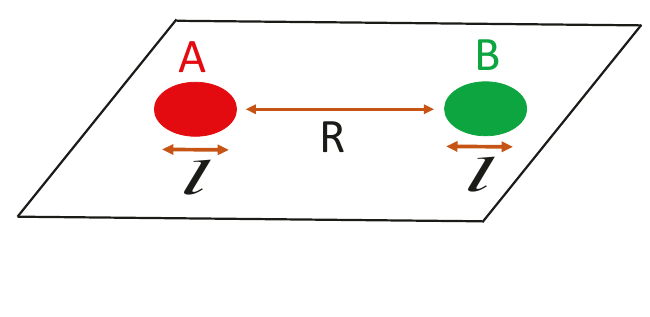
Figure 1 . The choice of subsystem A and B to define the REE E R ( ρ AB